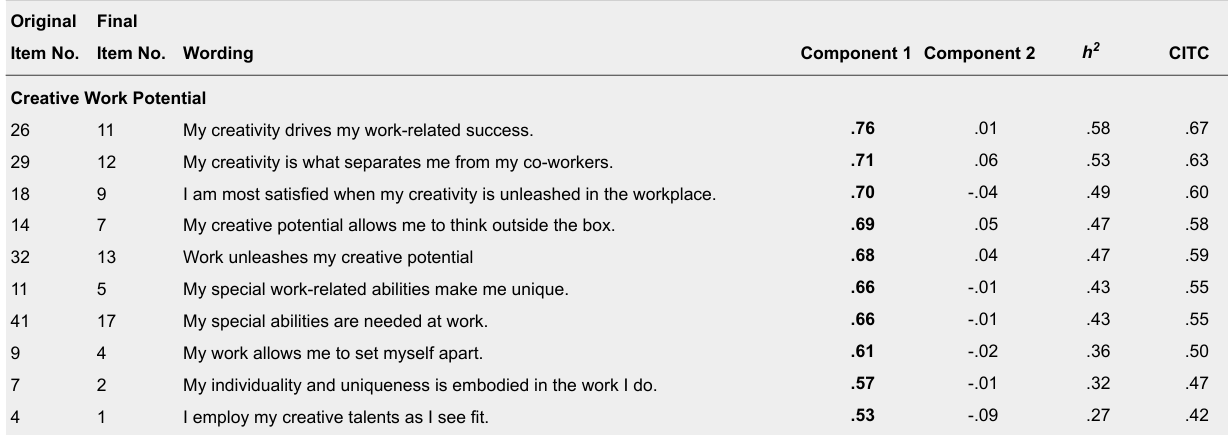
Summary of Study 1 ADS Items and Pattern Coefficients From Principal Components Analysis With Promax Rotation (N =